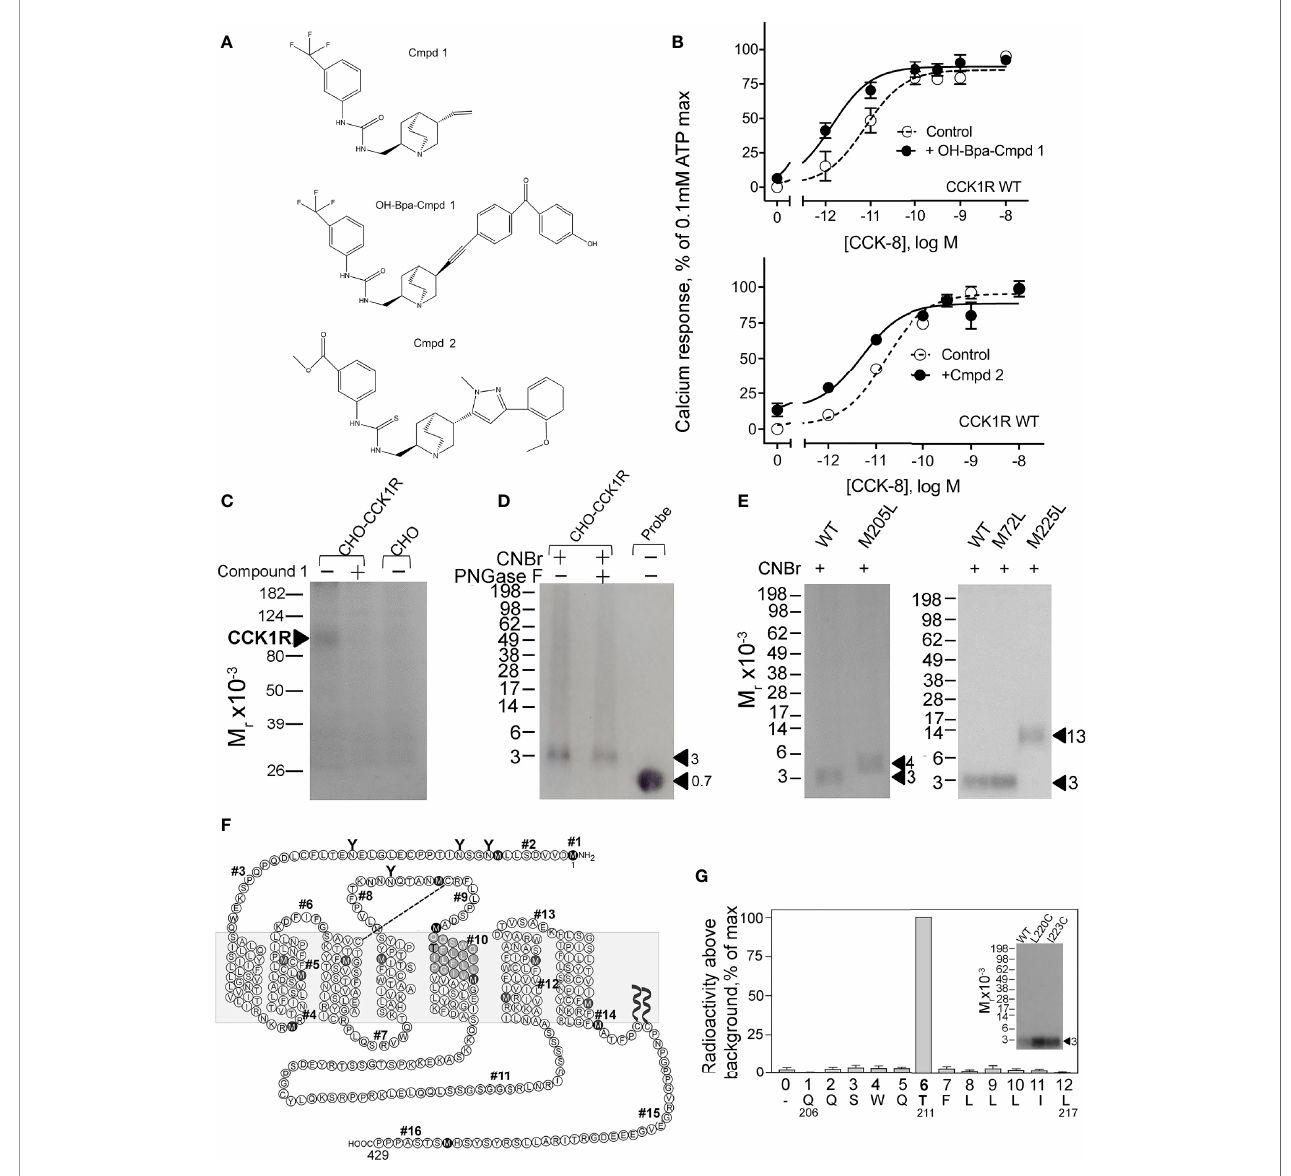
FIGURE 5 | Characterization of OH-Bpa-Compound 1 and identi fi cation of its site of labeling CCK1R. Shown in (A) are the chemical structures of compounds. (B) shows the impact of 10 µM OH-Bpa-Compound 1 and Compound 2 on intracellular calcium responses to CCK-8 in CHO-CCK1R cells. Values are expressed as percentages of the intracellular calcium responses to maximal stimulation by 0.1 mM ATP and data points represent means ± S.E.M. of data from a minimum of three independent experiments performed in duplicate. (C) shows a representative autoradiograph of membranes from cells labeled with the radioligand and separated on a 10% SDS-PAGE gel. This resulted in labeling a band migrating at M r = 85 – 95,000 representing CCK1R, with labeling inhibited by unlabeled Compound 1. No labeling was observed for non-receptor-bearing CHO cell membranes. (F) shows a diagram that illustrates the theoretical fragments resulting from CNBr cleavage of wild type rat CCK1R, with predicted molecular mass of each fragment shown in Table 2 . (D) shows a representative autoradiograph of 10% Bis-Tris NuPAGE gels used to separate products of CNBr cleavage of the CCK1R band labeled with OH-Bpa-Compound 1. This non-glycosylated band migrated at approximate M r = 3,000. (E) illustrates representative autoradiographs of 10% Bis-Tris NuPAGE gels used to separate products of CNBr cleavage of labeled CCK1R constructs in which speci fi c sites of CNBr cleavage were modi fi ed. The region of covalent labeling was de fi nitively identi fi ed as fragment #10, shown by appropriate changes in migration when Met residues at either end of this fragment were replaced by Leu. Cleavage of the labeled receptor M205L mutant yielded a band migrating at approximate M r = 4,200 and that of the labeled receptor M225L mutant yielded a band migrating at approximate M r = 13,000. (G) shows that adding Cys residues to fragment #10 to allow its covalent attachment to beads for Edman degradation sequencing did not interfere with the af fi nity labeling (inset) and the pro fi le of elution of radioactivity from Edman degradation sequencing of the puri fi ed Gln 206 -Leu 217 fragment resulting from CNBr cleavage of these constructs. The peak in eluted radioactivity was consistently observed in cycle 6 in four independent experiments. This corresponds to covalent attachment of the OH-Bpa- Compound 1 probe to residue Thr 211 at the top of TM5 of the